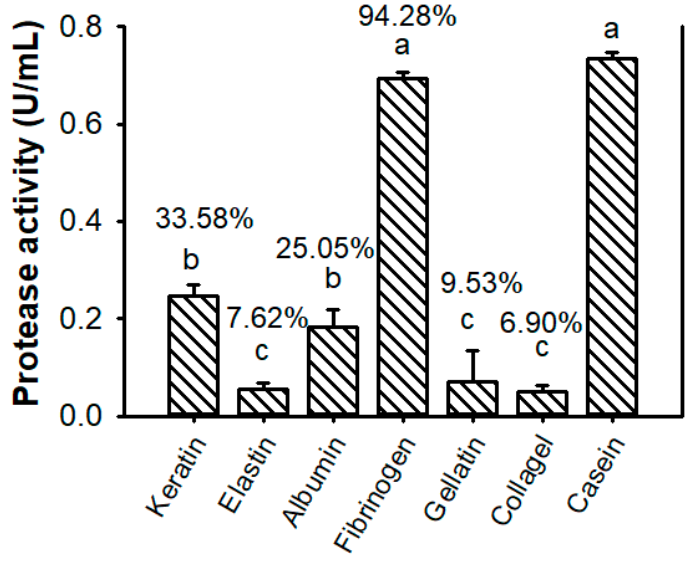
Figure 7. Substrate specificity of Paenibacillus sp. TKU047 protease. All points on the graph indicate the mean of each experiment (with n = 3) and standard deviation (error bar). Different letters (a, b, c, and d) indicate significant difference based on Tukey’s test with p < 0.05. The values on top of the bars (%) are the ratios of the activities of TKU047 protease on different substrates to those on casein.